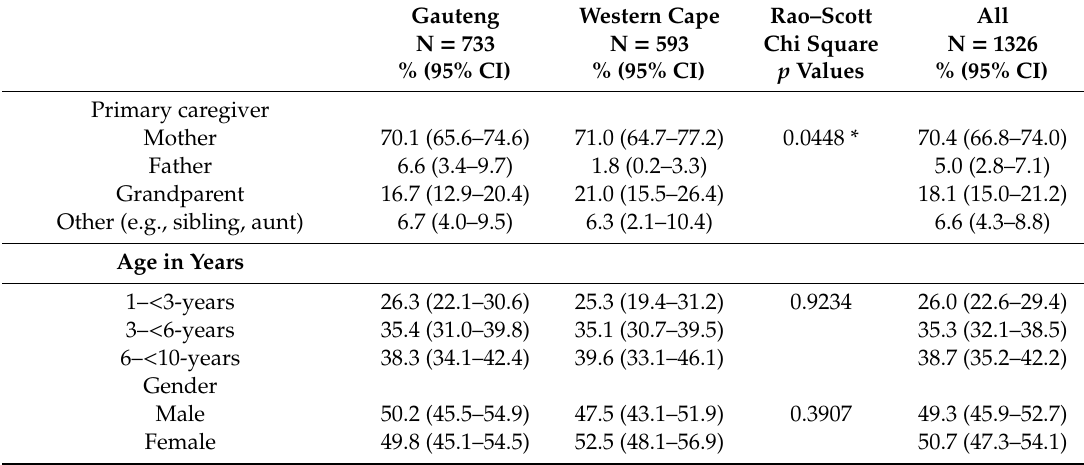
Table 2. Sociodemographic and other characteristics of the 1– < 10-year-old children in the two provinces